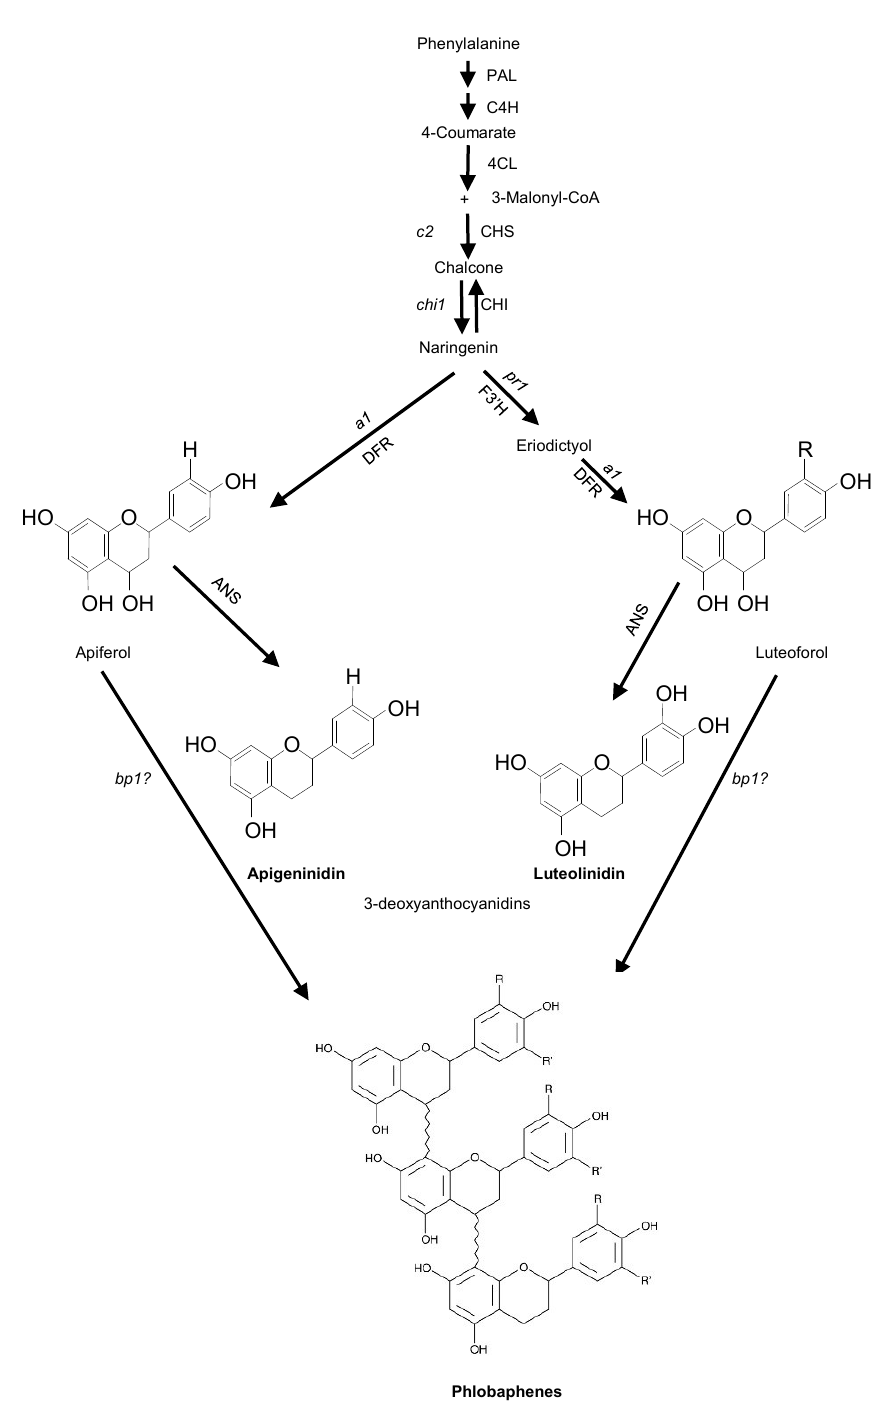
Figure 1. Schematic representation of the biosynthetic pathway of flavonoid compounds. Enzyme names are (gene names in parentheses): PAL, Phenylalanine ammonia lyase; C4H, Cinnamate-4-hydroxylase; 4CL, 4-coumarate: coenzymeA ligase; C3'H, p-coumarate 3'-hydroxlase; CHS ( c2 ), Chalcone synthase; CHI ( chi1 ), Chalcone isomerase, DFR ( a1 ), Dihydroflavonol reductase; and F3'H, Flavonoid 3'-hydroxylase ( pr1 ). Pathway modeled after